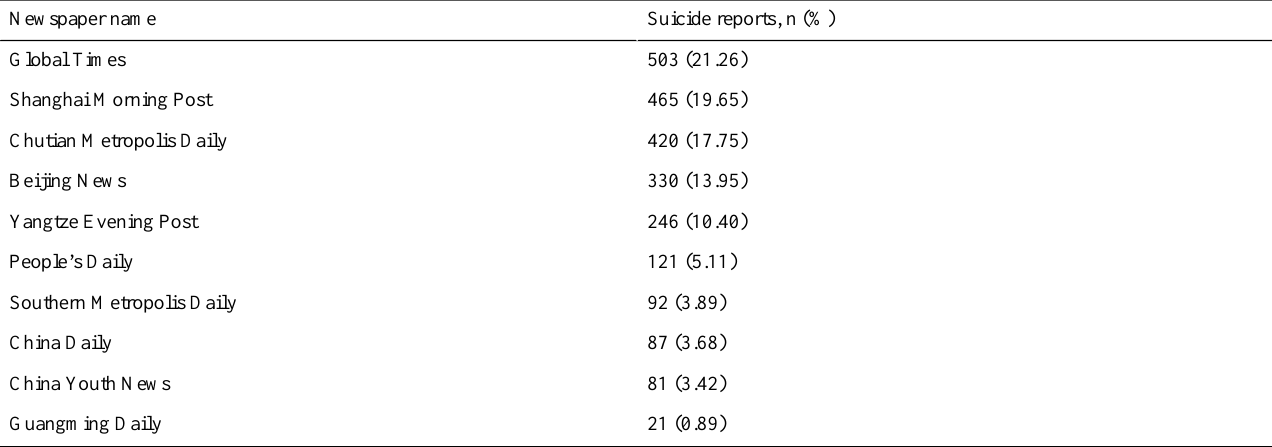
Table 2. Suicide reporting by national and local Chinese publishers